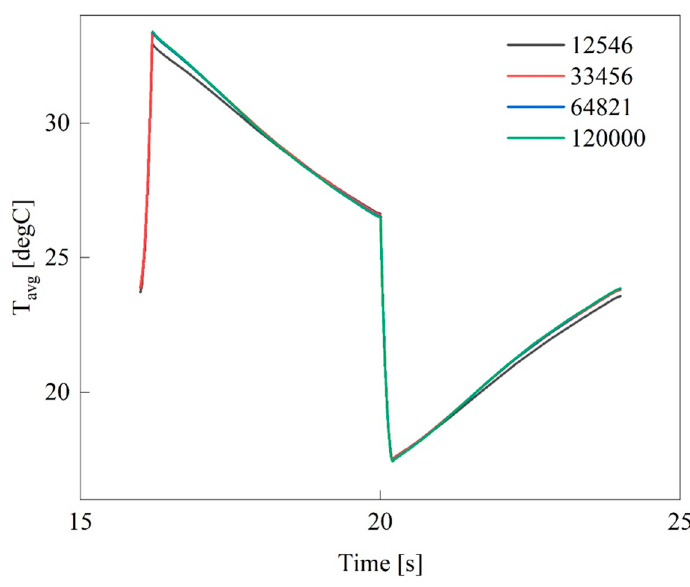
Figure 6. The verification of grid